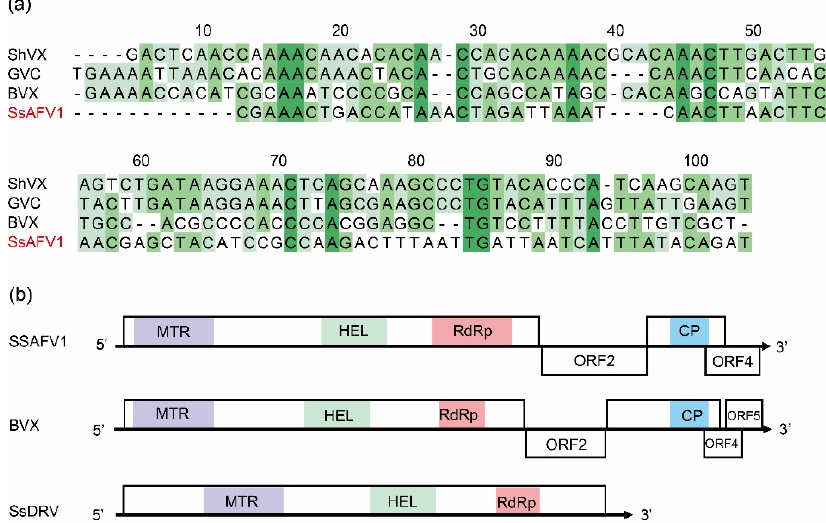
Figure 3. Genomic characteristics of SsAFV1. ( a ) Alignments of the nucleotide sequences of 5 ′‐ untranslated regions (UTRs) of SsAFV1 and selected viruses. ( b ) Schematic diagram of three fungal alphaflexivirus, SsAFV1, BVX, and SsDRV. Four conserved domains are shown as rectangular boxes in different colors. MTR, methyl transferase; HEL, RNA helicase; RdRp, RNA-dependent RNA polymerase; CP, coat